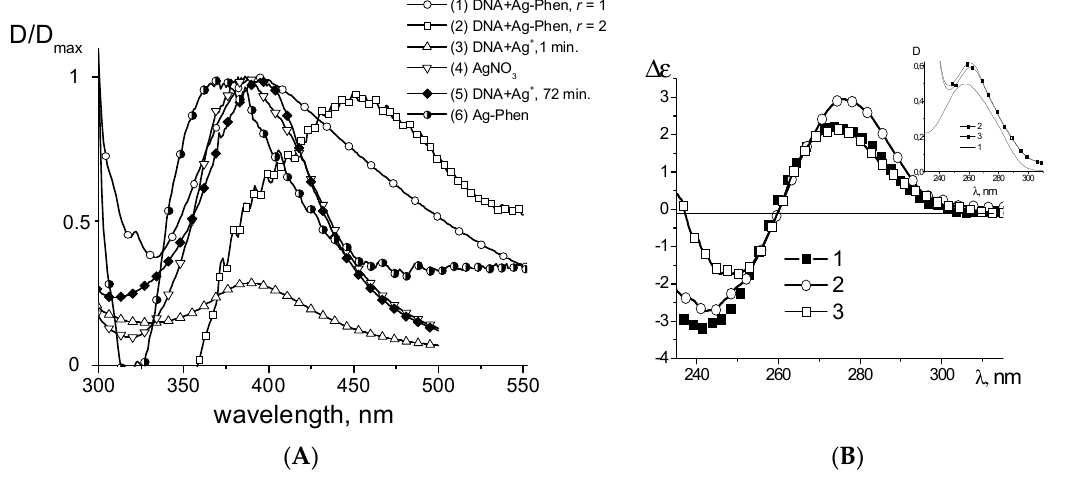
Figure 9. ( A ) Plasmon resonance peak (relative change) that appears as a result of silver reduction with NaBH 4 in AgNO 3 solution (4) after the adding of NaBH 4 into DNA solution with AgNO 3 : in 1 min (3) and in 72 min (5); the result of silver reduction in Ag–Phen solution (6), after formation of Ag–Phen complexes with DNA at С (DNA) = 0.0035%, C (Ag–Phen) = C (NaBH 4 ) = 1.2 × 10 − 4 M, r = 2 (2); and at C (DNA) = 0.008%; C (Ag–Phen) = 1.14 × 10 − 4 M; C (NaBH 4 ) = 1.5 × 10 − 3 M, r = 1 (1). ( B ) CD spectra for DNA (1), DNA in complexes with Ag–Phen (2) and same solution after the reduction of silver (3); insert: UV absorption spectra for same solutions. C (DNA) = 0.0025%, C (Ag–Phen) = С (NaBH 4 ) = 0.5 × 10 − 5 M, r = 0.4.